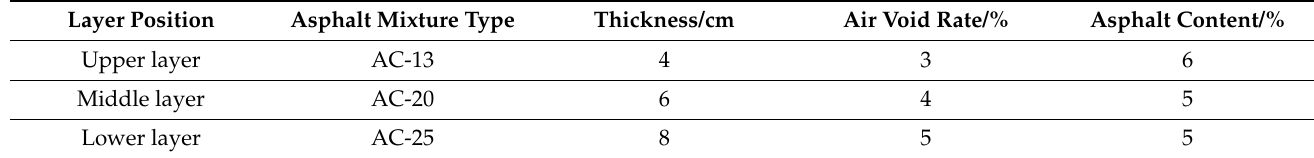
Table 2. Gradation of coarse aggregates in AC-13, AC-20 and AC-25.